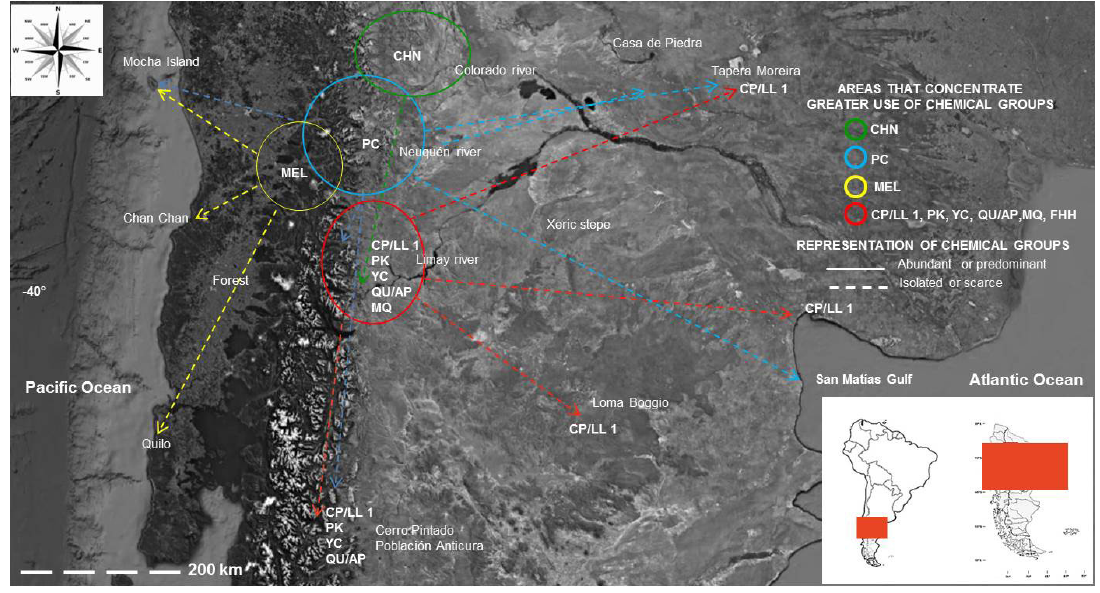
Figure 2. Obsidian distribution of the northern Patagonian Andes and La